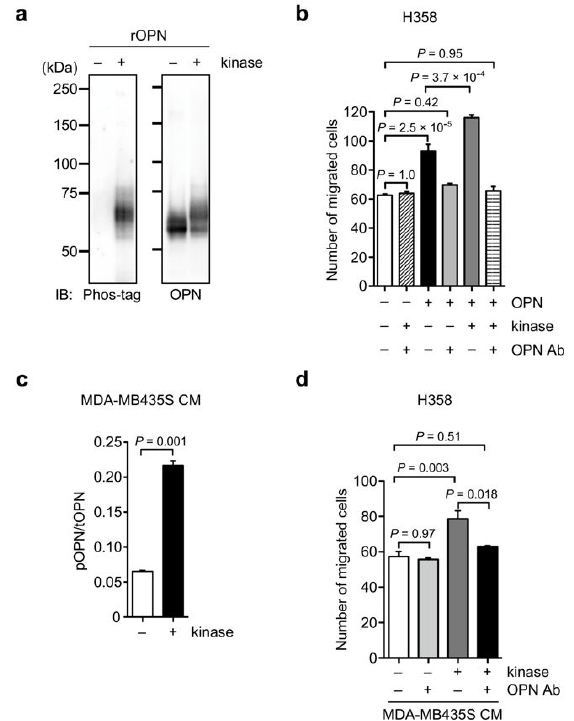
Figure 6. Induction of cancer cell migration by phosphorylated OPN. ( a ) Western blot analysis of phosphorylation using phos-tag in a recombinant OPN after kinase treatment. The unprocessed blot image is shown in Figure S3. ( b ) Cell migration of H358 cells in the presence or absence of recombinant OPN pretreated with kinase and OPN function-blocking antibody (OPN Ab) either separately or in combinations. One-way ANOVA and Tukey post-hoc test, mean ± SEM of three independent assays conducted in triplicate. ( c ) Phos-tag ELISA analysis of phosphorylated OPN in MDA-MB435S CM after kinase treatment. Two-tailed unpaired Student’s t -test, mean ± SEM of three independent assays conducted in triplicate. ( d ) Cell migration of H358 cells in the presence or absence of the MDA-MB435S CM pretreated with kinase and OPN function-blocking antibody (OPN Ab), either separately or in combination. – and + indicate treatment without and with the indicated reagent. One-way ANOVA and Tukey post-hoc test, mean ± SEM of three independent assays conducted in